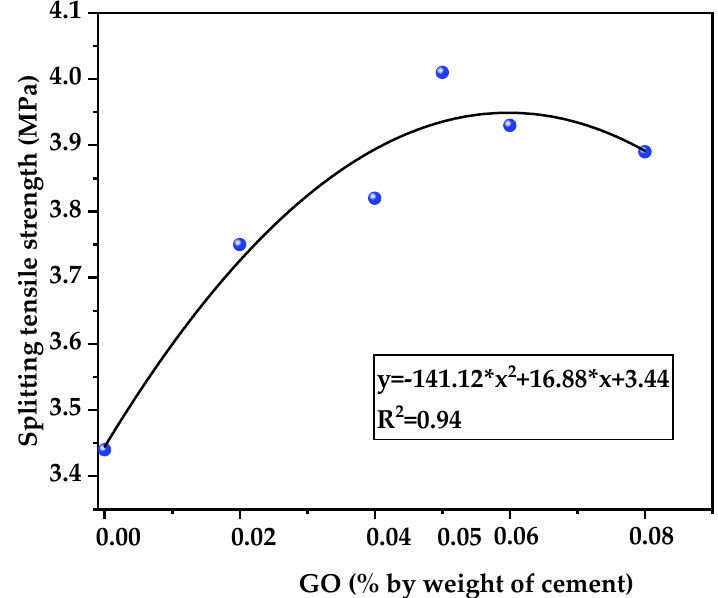
Figure 5. Relationship between GO and the 28-day splitting tensile strength.